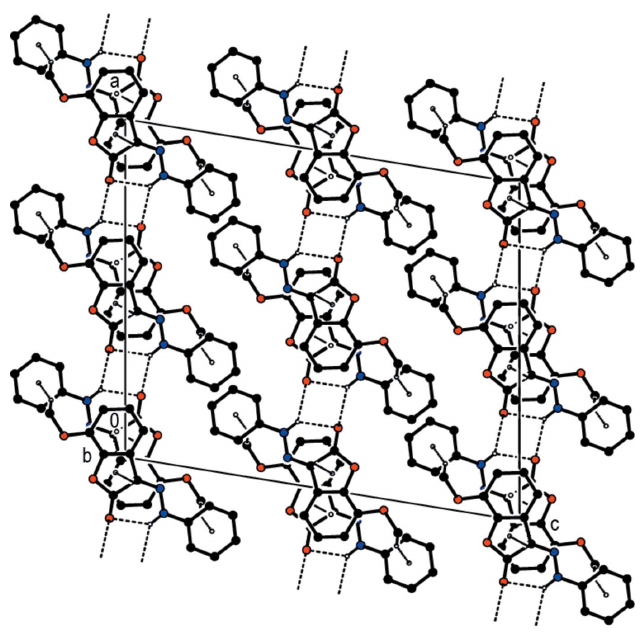
Figure 4 A view of the molecular packing of the title compound along the b- axis direction. Intermolecular interactions are depicted as in Fig. 2.